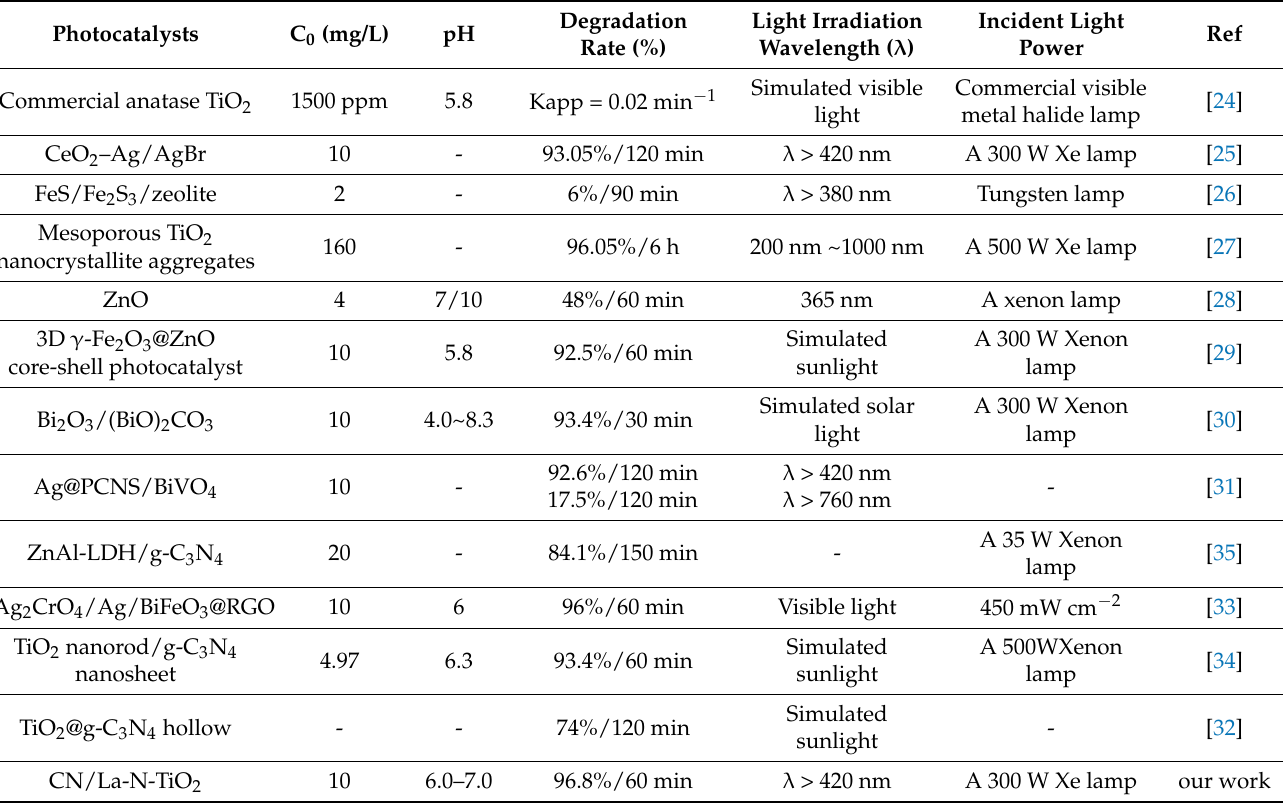
C 0 : the initial concentration. PMS: